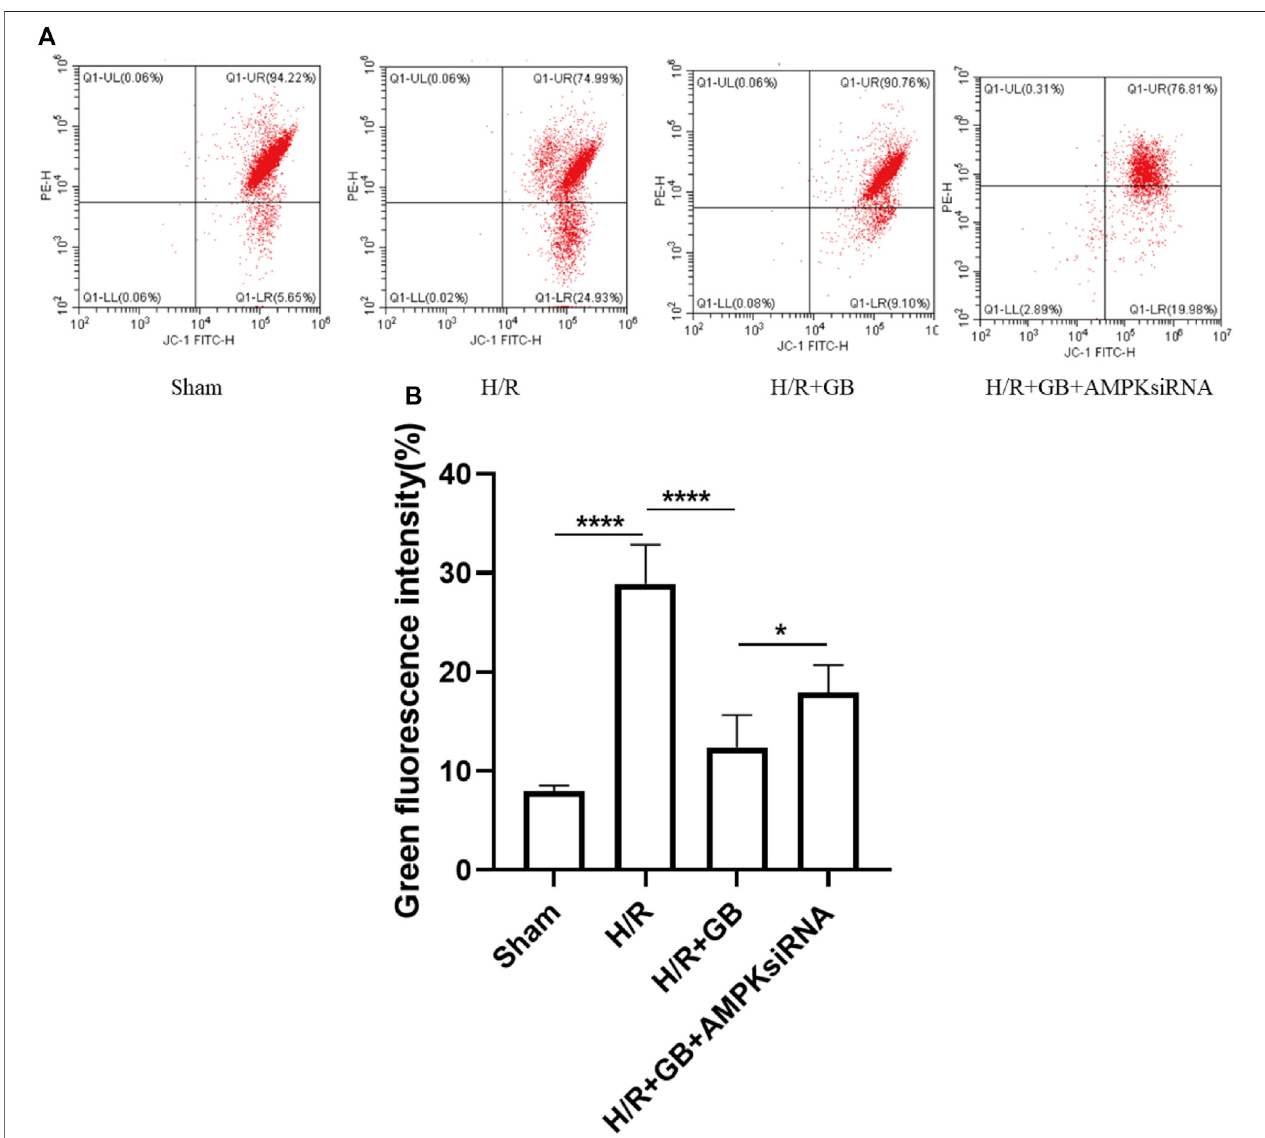
FIGURE3| MMPmeasured via FACS (A) .Bargraphsshowingtheratioofgreen/redrateinthecellssubjectedtovarioustreatments (B) .Dataareexpressedasthe mean ± SEM and represent 3 distinct experiments. (* p < 0.05, **** p < 0.0001).